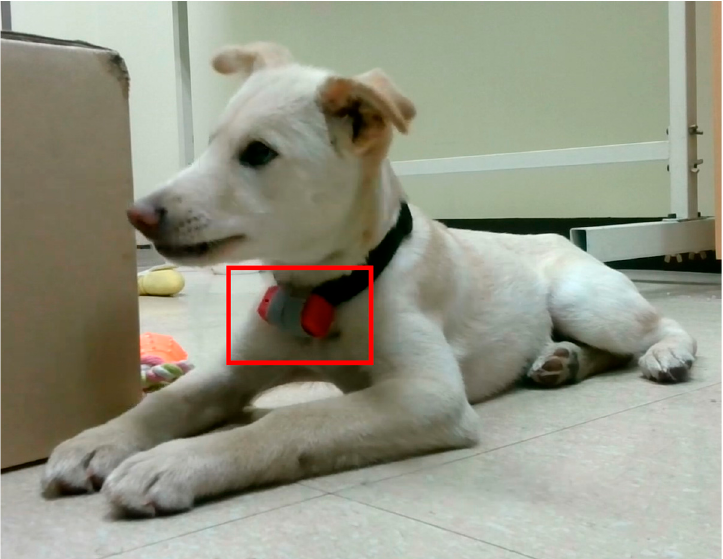
Table 4. Experimental dataset con fi guration. Figure 8. Wearable device example in the red rectangle on a dog. Figure 8. Wearable device example in the red rectangle on a